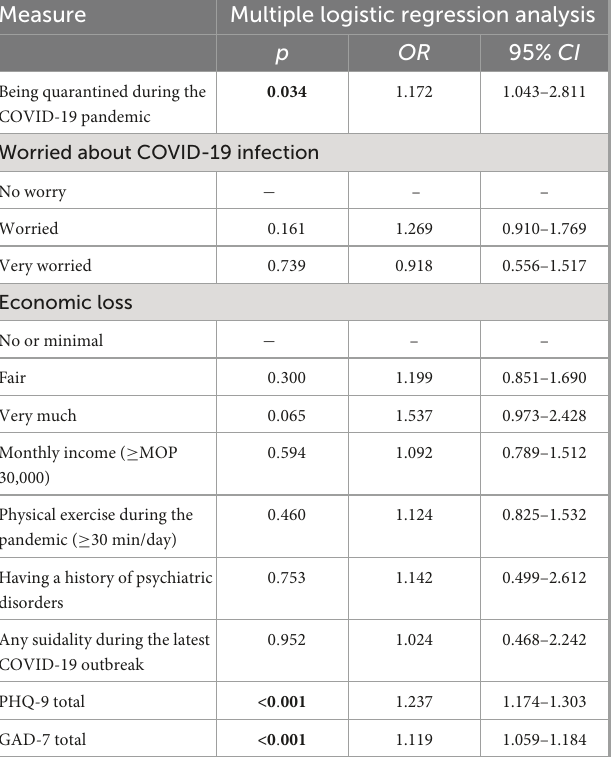
TABLE 2 Independent correlates of insomnia among Macau residents during the COVID-19 pandemic ( N = 1,008). Measure Multiple logistic regression